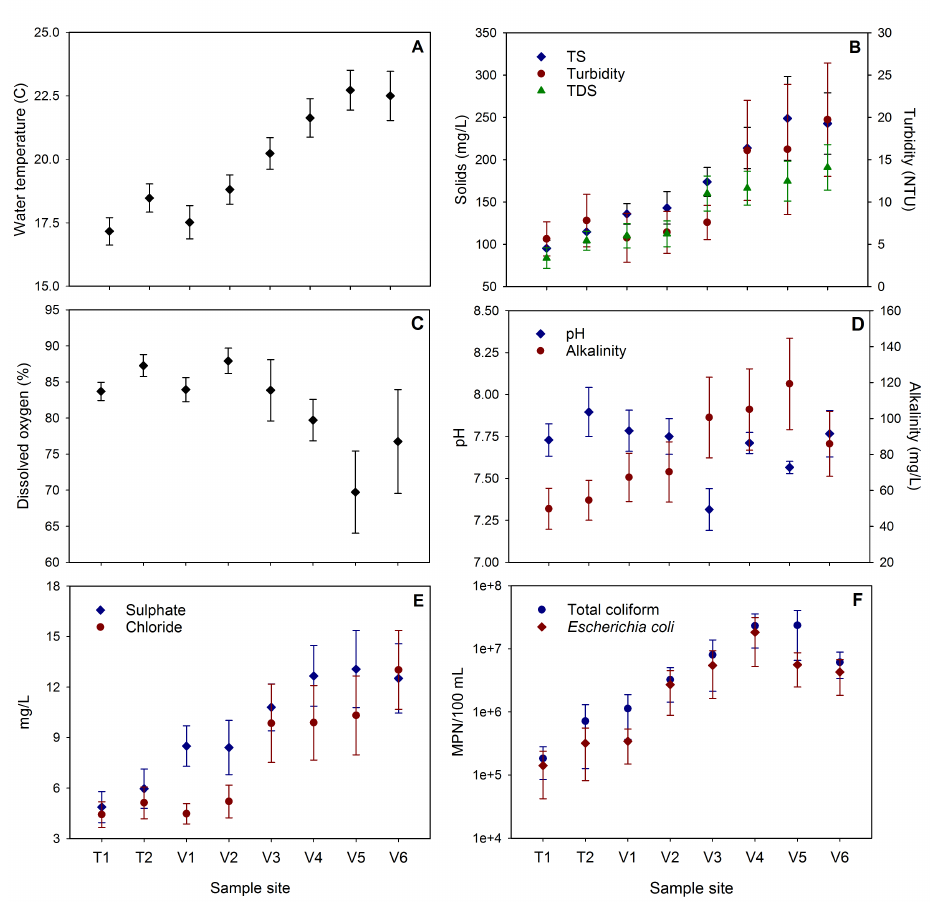
Figure A1. Spatial variation of some parameters in the study area (Average and standard error). ( A ) water temperature. ( B ) total solids (TS), turbidity and total dissolved solids (TDS). ( C ) dissolved oxygen. ( D ) pH and alkalinity. ( E ) sulphate and chloride. ( F ) total coliform and Escherichia coli